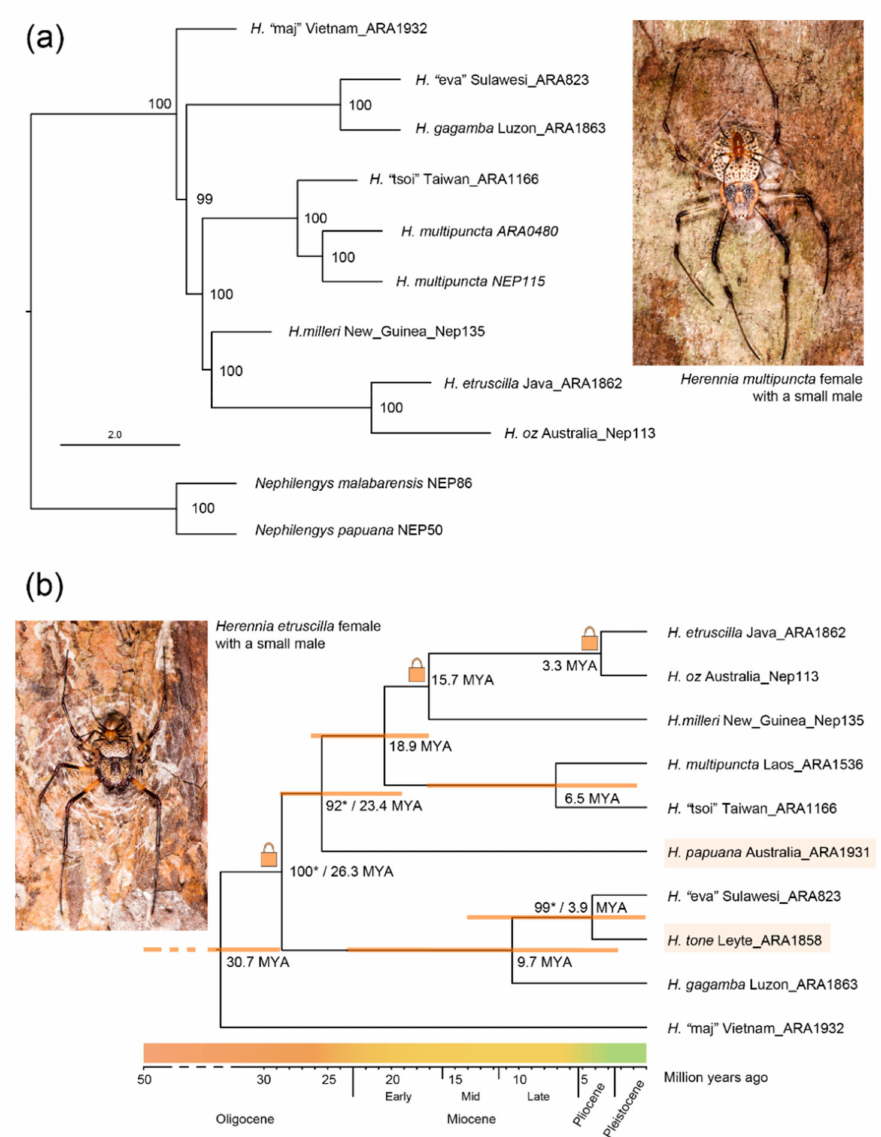
Figure 3. Species-level phylogenies of coin spiders. ( a ) AHE-only phylogeny produced with AS- TRAL [35], resolving the relationships between eight species of Herennia with Nephilengys as the outgroup as per Kuntner et al. [6]; ( b ) Species-level phylogeny of the available ten species of Herennia , calculated from COI data. Highlighted are two species lacking AHE data, H. papuana and H. tone . The lock symbols denote age-constrained nodes. Supports for nodes not present in the AHE-only phylogeny (marked with an asterisk) were recovered by